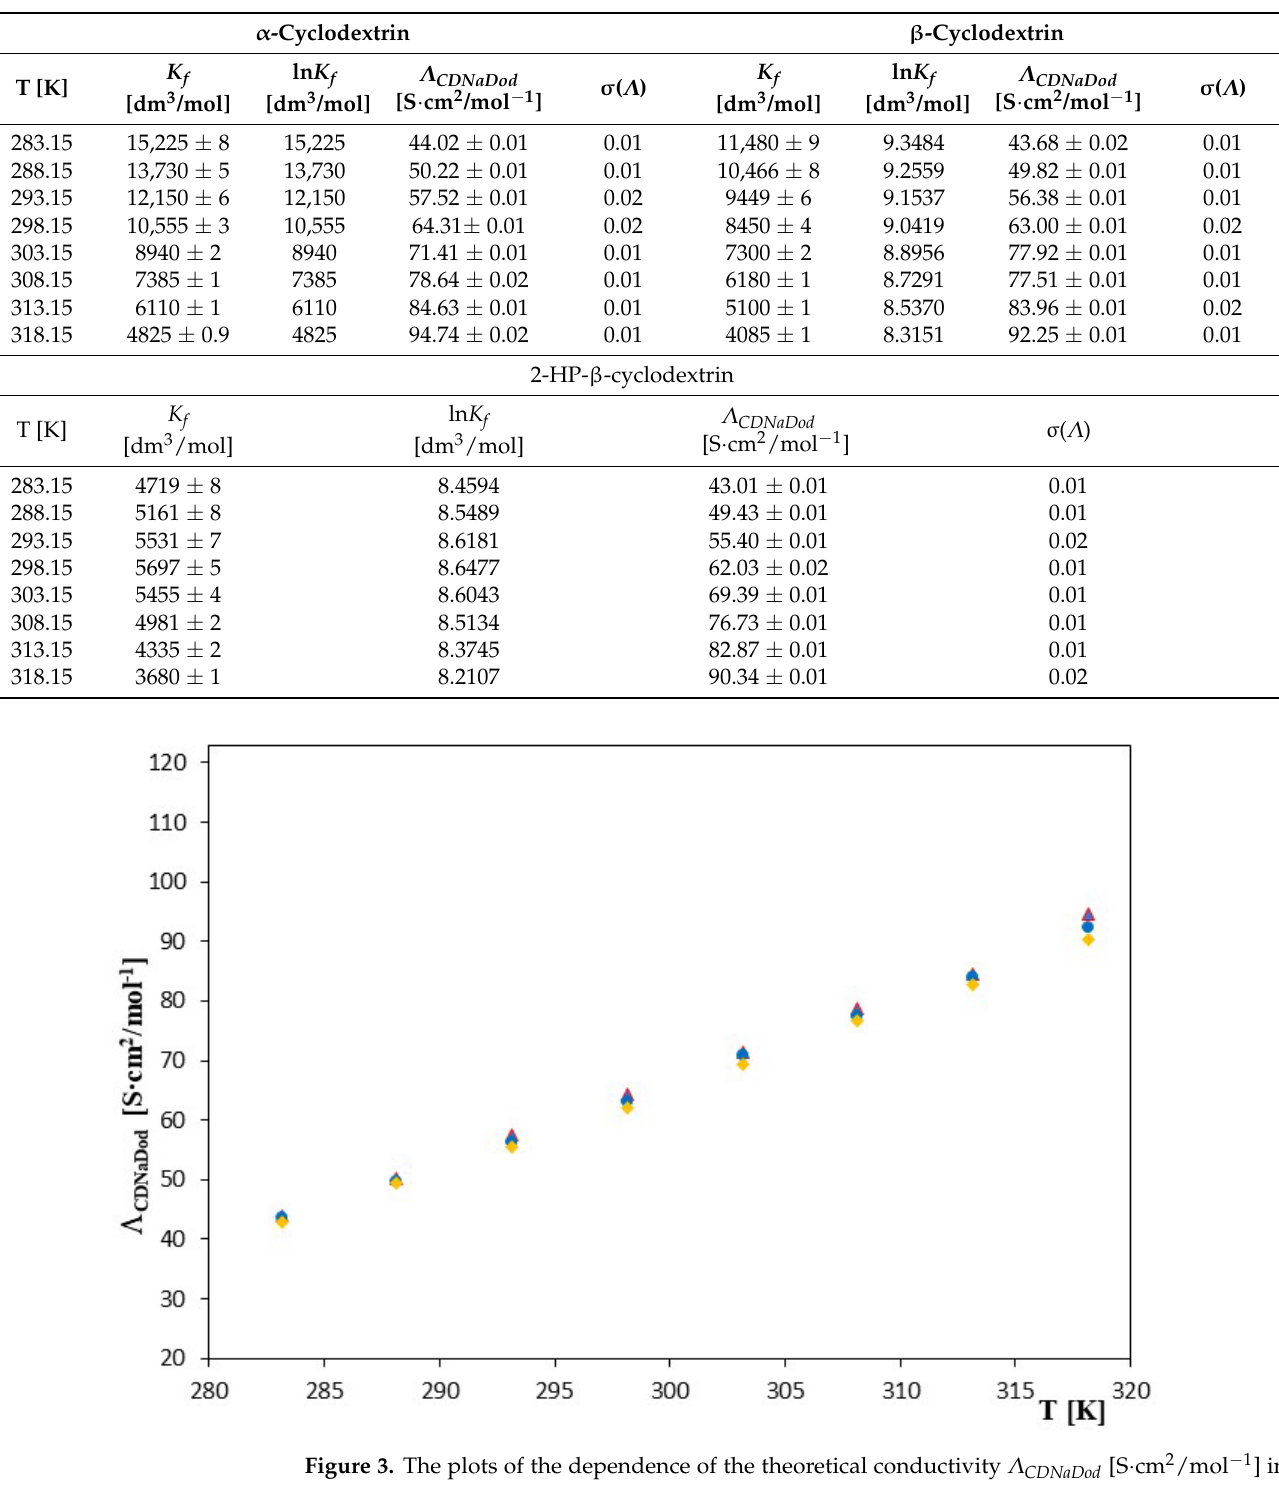
Table 1. The value of constant formation K f [dm 3 /mol] and theoretical conductivity Λ CDNaDod